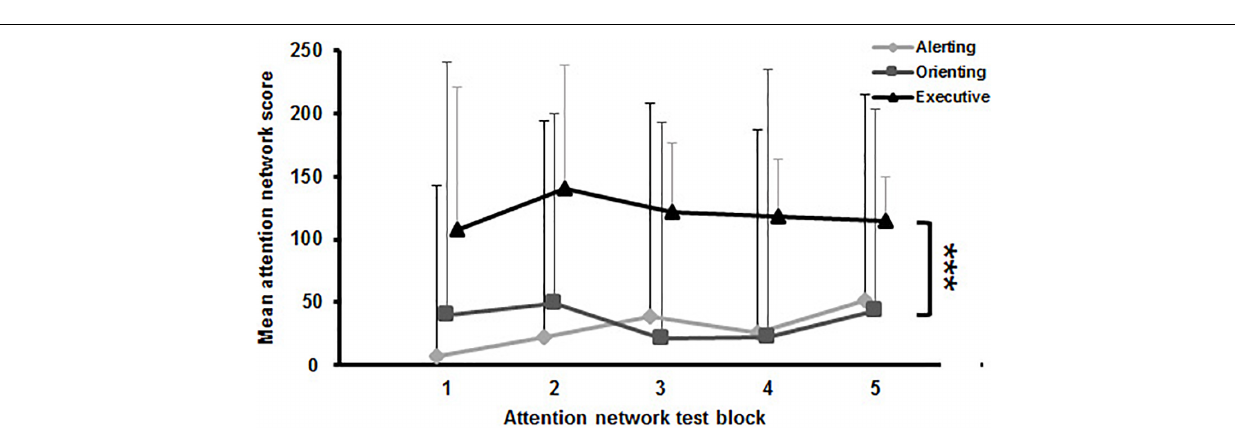
FIGURE 2 | Mean attention network scores with standard deviation of the attention network test across blocks. The significant main effect for network is indicated by the bracket with asterisk; *** p <